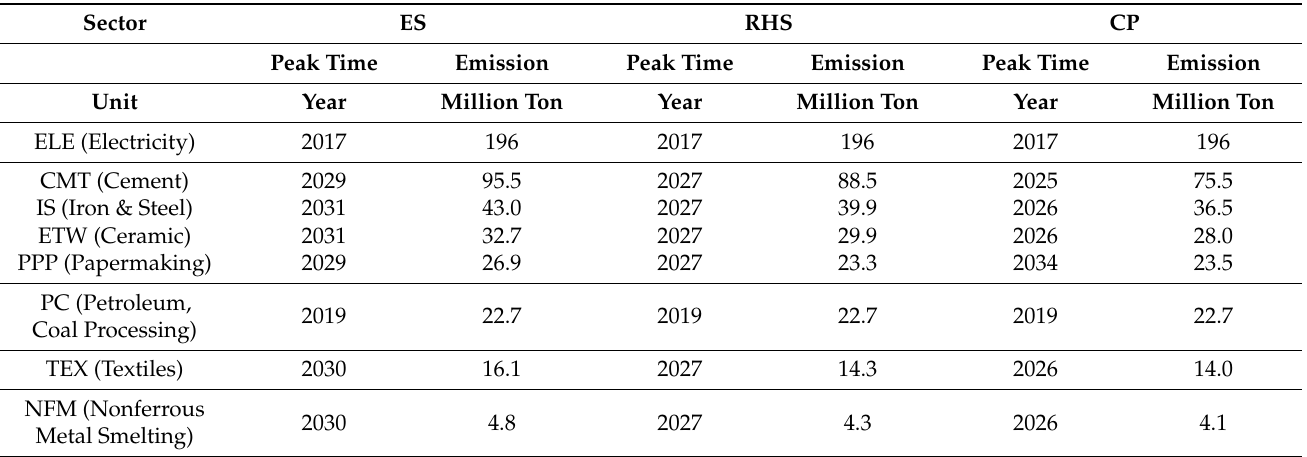
Table 5. Carbon peak time of high emissions industries in different